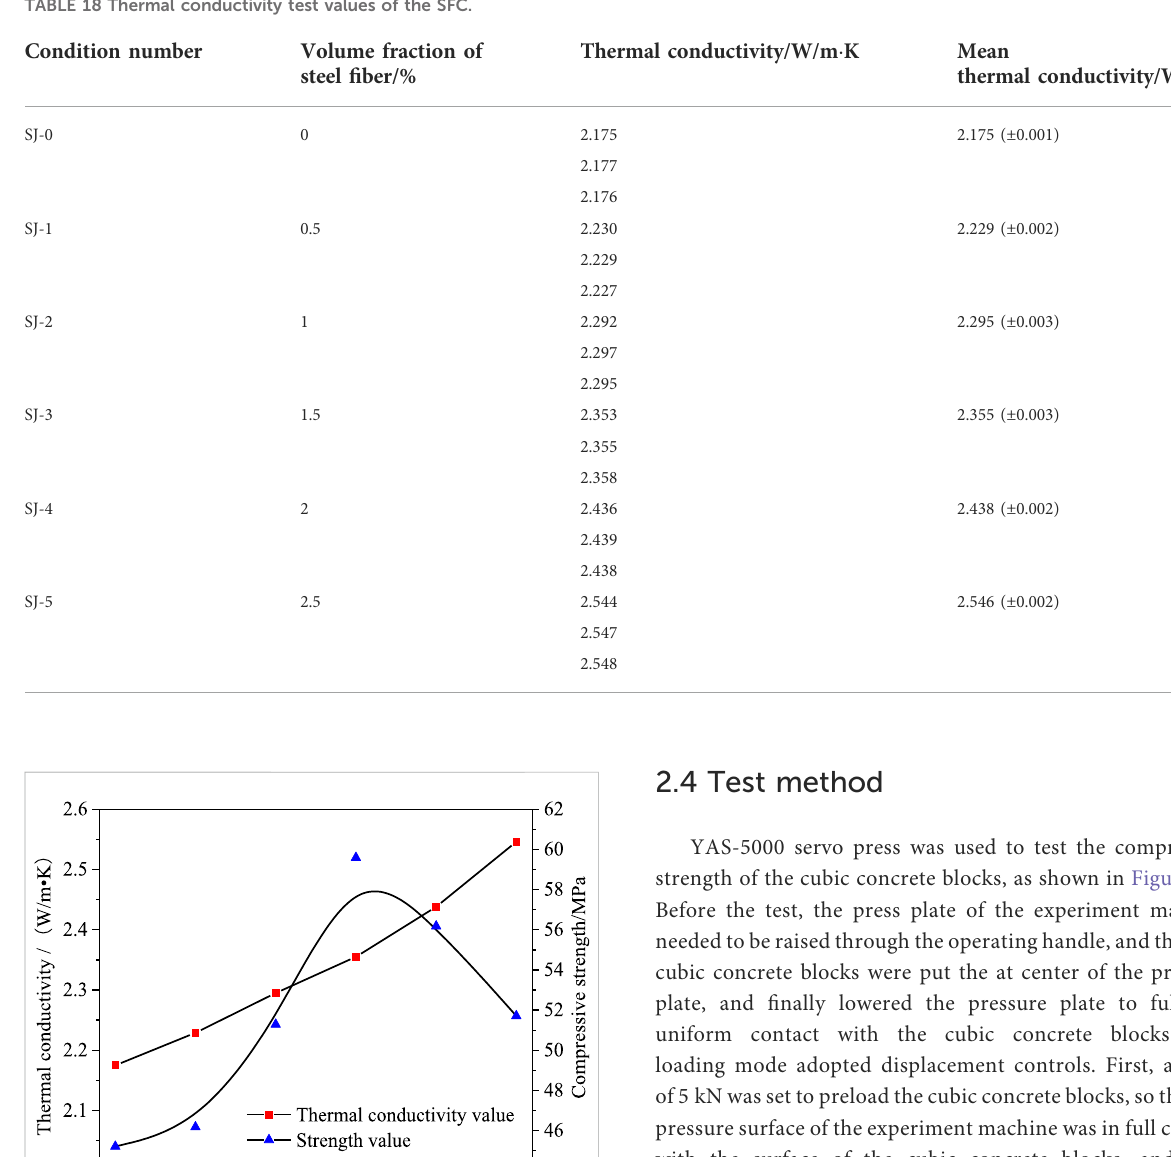
TABLE 18 Thermal conductivity test values of the SFC.